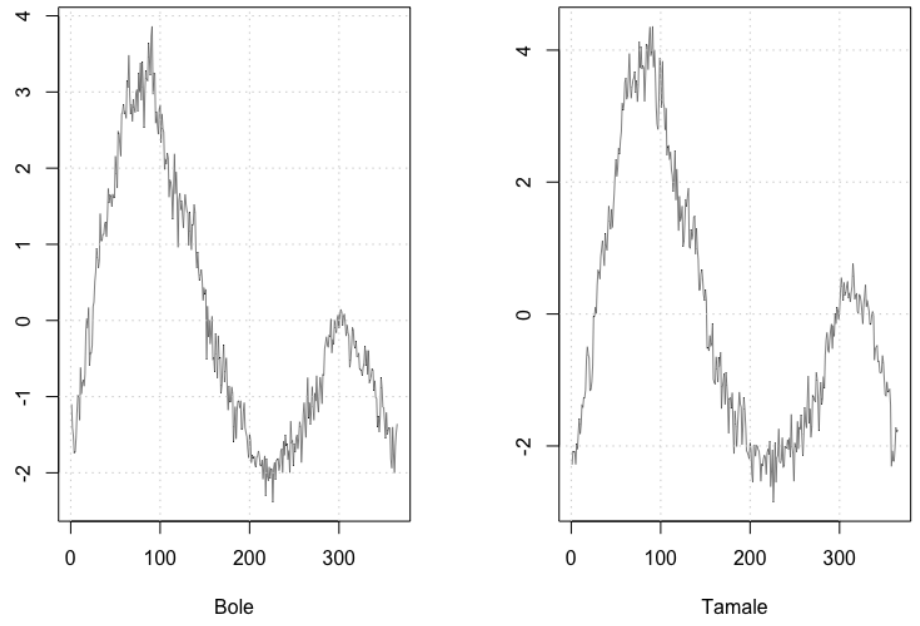
Figure 6. Estimated seasonal figure of the daily average temperature for Bole and